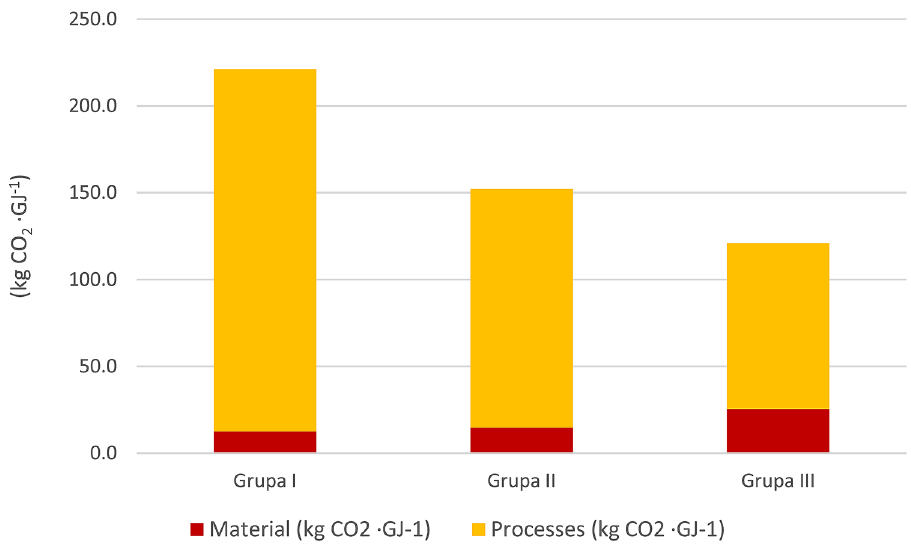
Figure 3. Structure of CO 2 emissions in area groups.